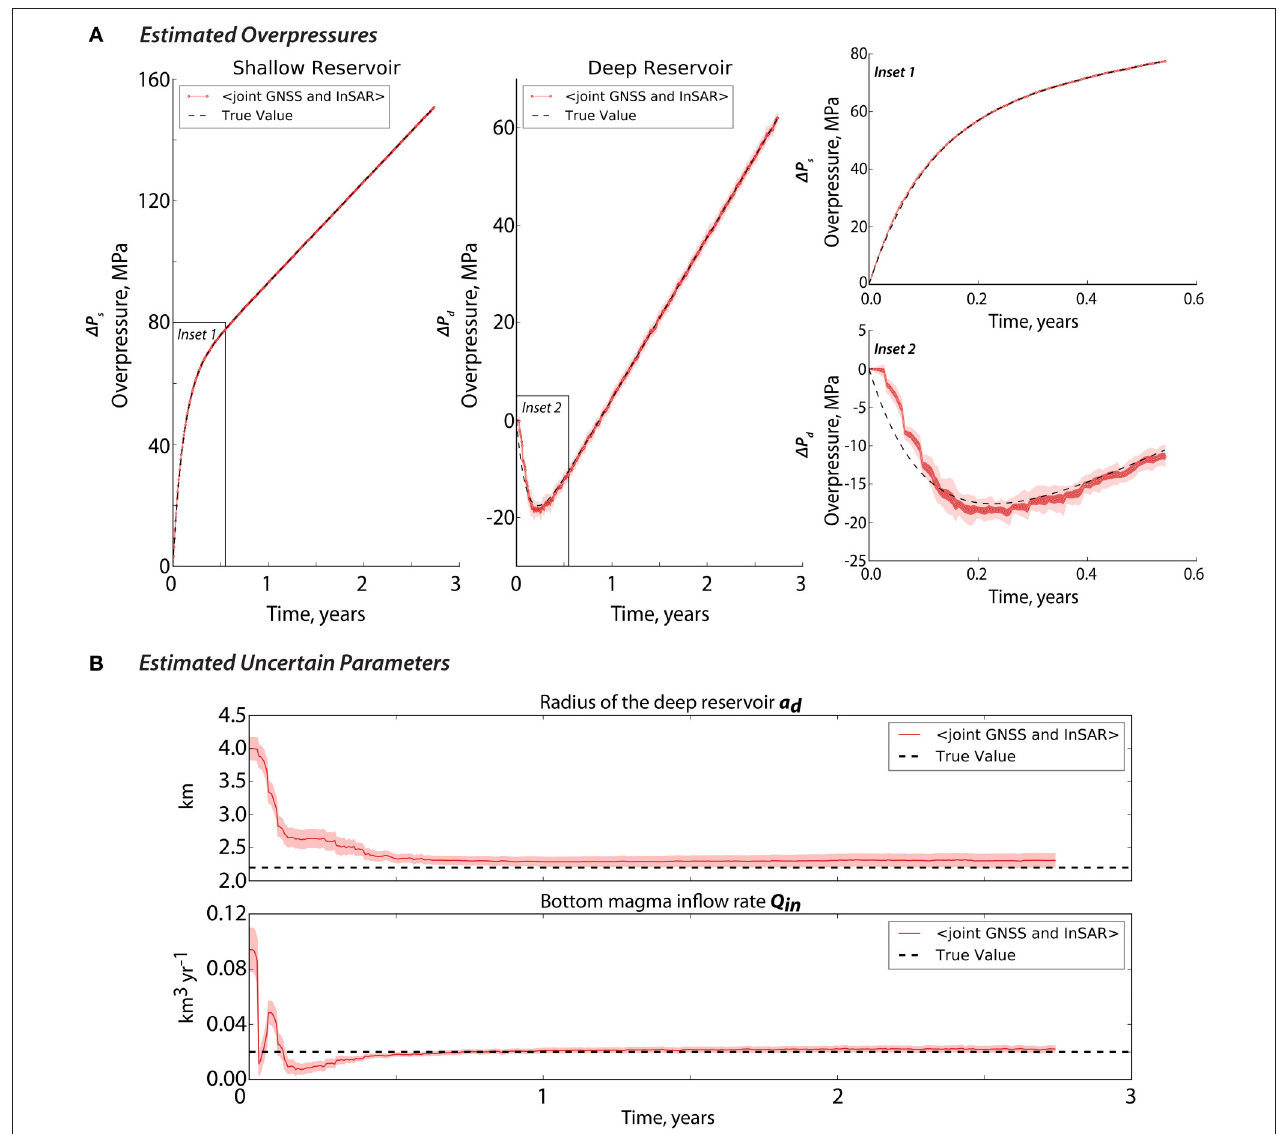
FIGURE 12 | The estimated overpressures (A) and uncertain parameters (B) after jointly assimilating GNSS (10 observations that are assimilated every time-step, f obs 1, with distance to the volcanic center ranging from 1 to 5 km) and InSAR-like observations (242 observations that are only assimilated every 12 days, = f obs 1 / 6, with distance to the volcanic center ranging from 1 to 5 √ 2 km). The initial conditions of the uncertain parameters are similar to those of in Figure 5C . The = inset in (A) provides a magnified view of the overpressures at the start of the assimilation. The pink shade corresponds to the spread (1 σ ). The black broken lines represent the true